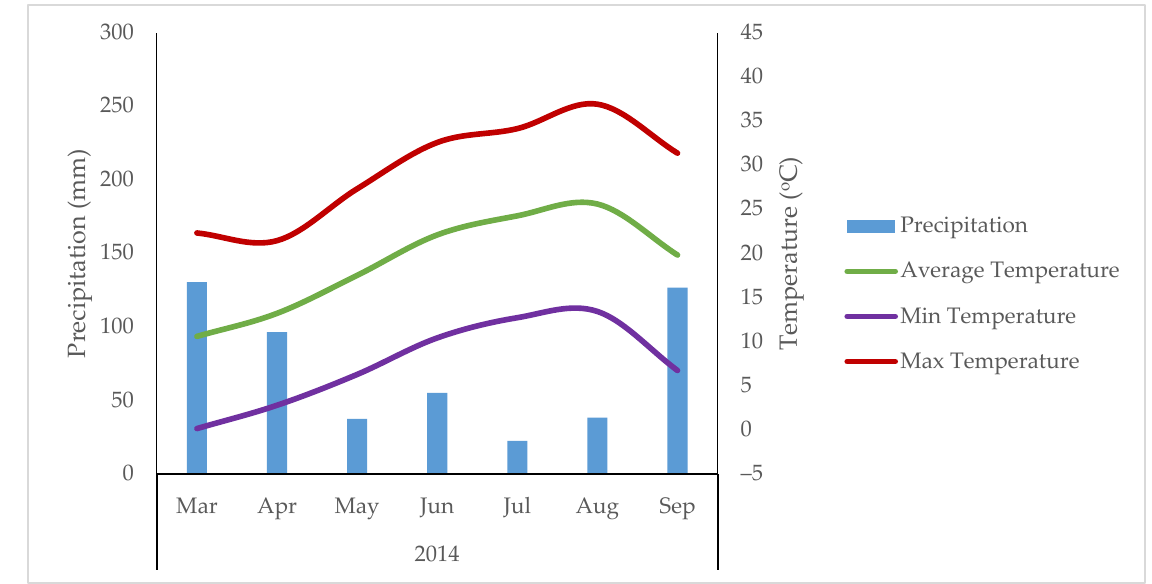
Figure 3. Meteogram of the 2014 vine growing season. Precipitation is expressed monthly, and resolution of temperature is not precise.